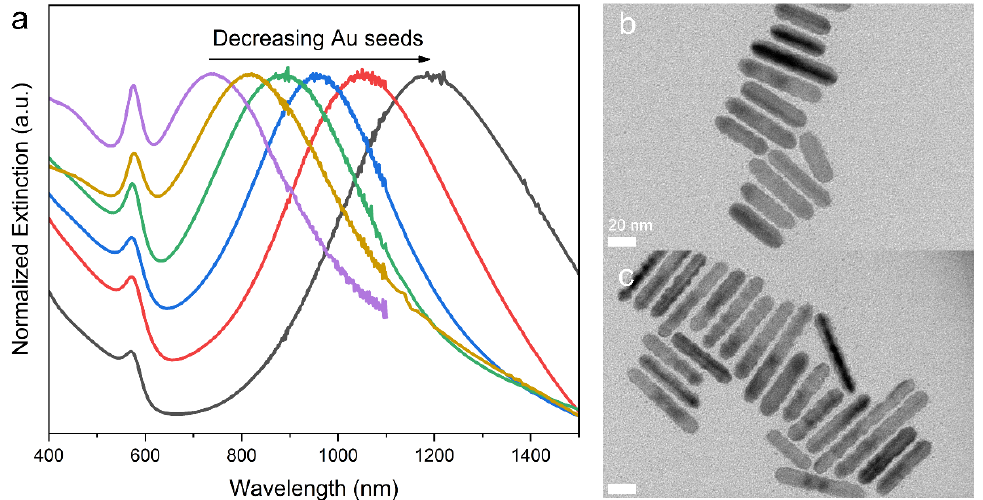
Figure 2. ( a ) Extinction spectra of Cu NRs with LSPRs located at 740 (purple), 821 (yellow), 888 (green), 960 (blue), 1054 (red) and 1190 nm (black). ( b , c ) TEM images of Cu NRs with LSPR of 740 nm ( b ) and 821 nm ( c ).